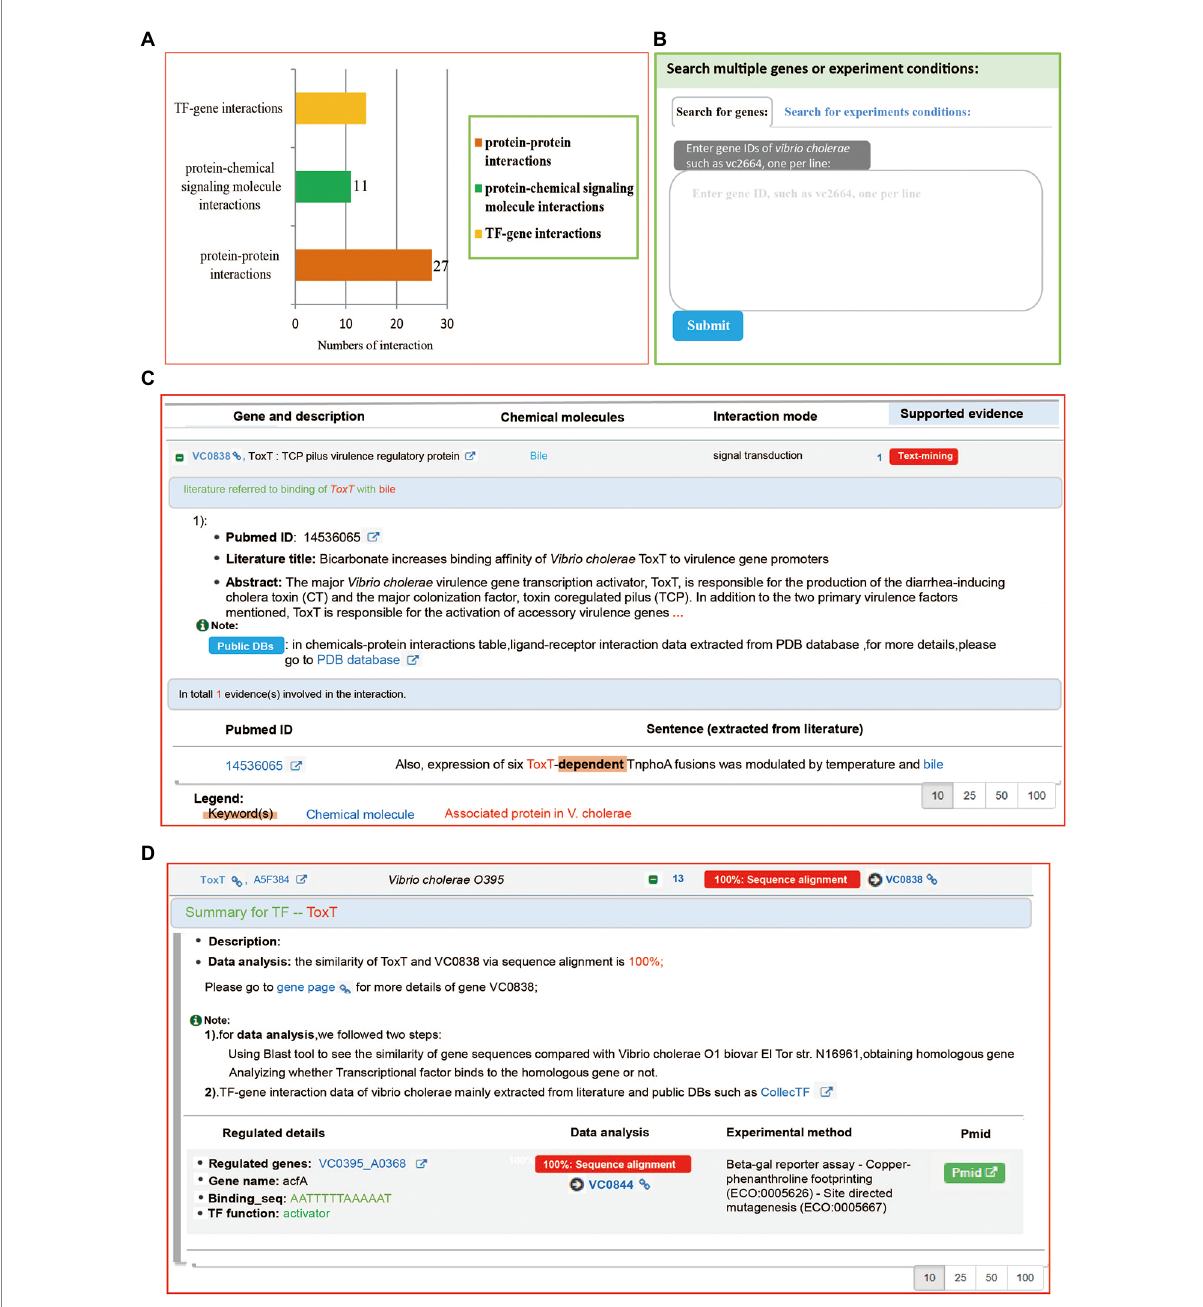
FIGURE 4 The “Experiments” page. (A) A barplot summarizing the interaction data associated with gene VC0803. The Y-axis represents interaction types, and the X -axis denotes the number of interactions. (B) The search function of the “Interactions” page. Two kinds of search methods: “Search by gene” and “Search by experiment conditions” were provided, allowing users to search what they are interested in. The search results are listed and visualized in an interactive network. (C) The protein-chemical signaling molecule interaction. The “VC0838-bile interaction” entry was supported by a sentence extracted from the literature. (D) The TF-gene interaction. Users can obtain regulated details they are interested in, including regulated genes, the binding site of transcription factors, and